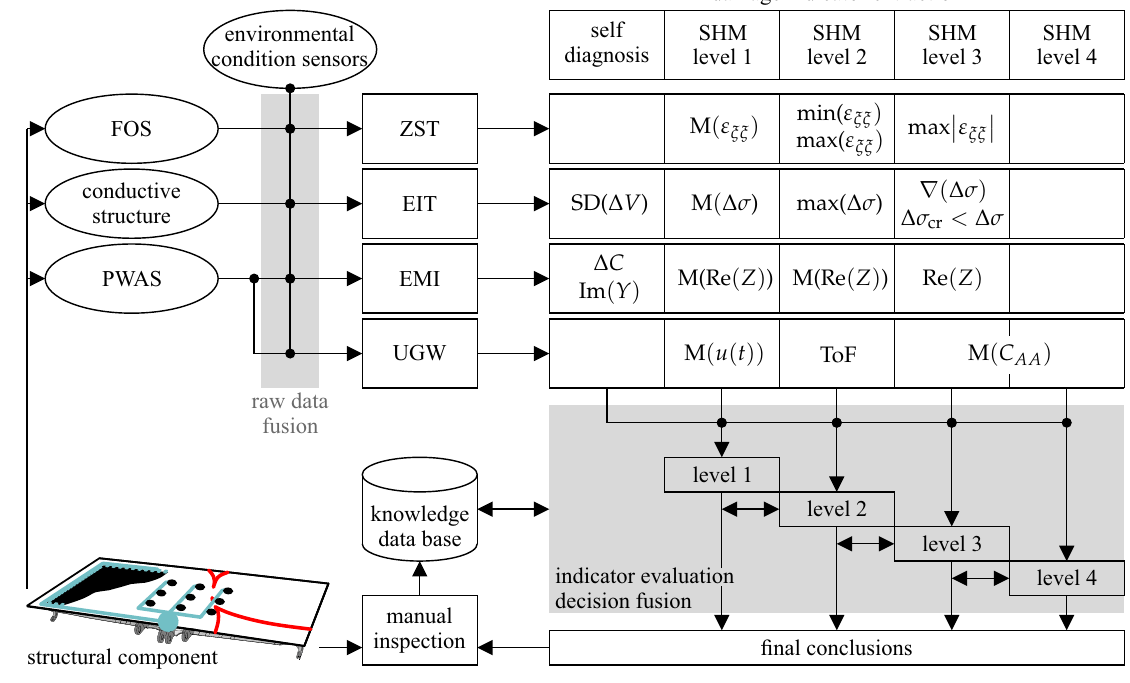
Figure 12. Data evaluation scheme of multi-sensor SHM approach. The illustration shows an aircraft spoiler as the monitored structural